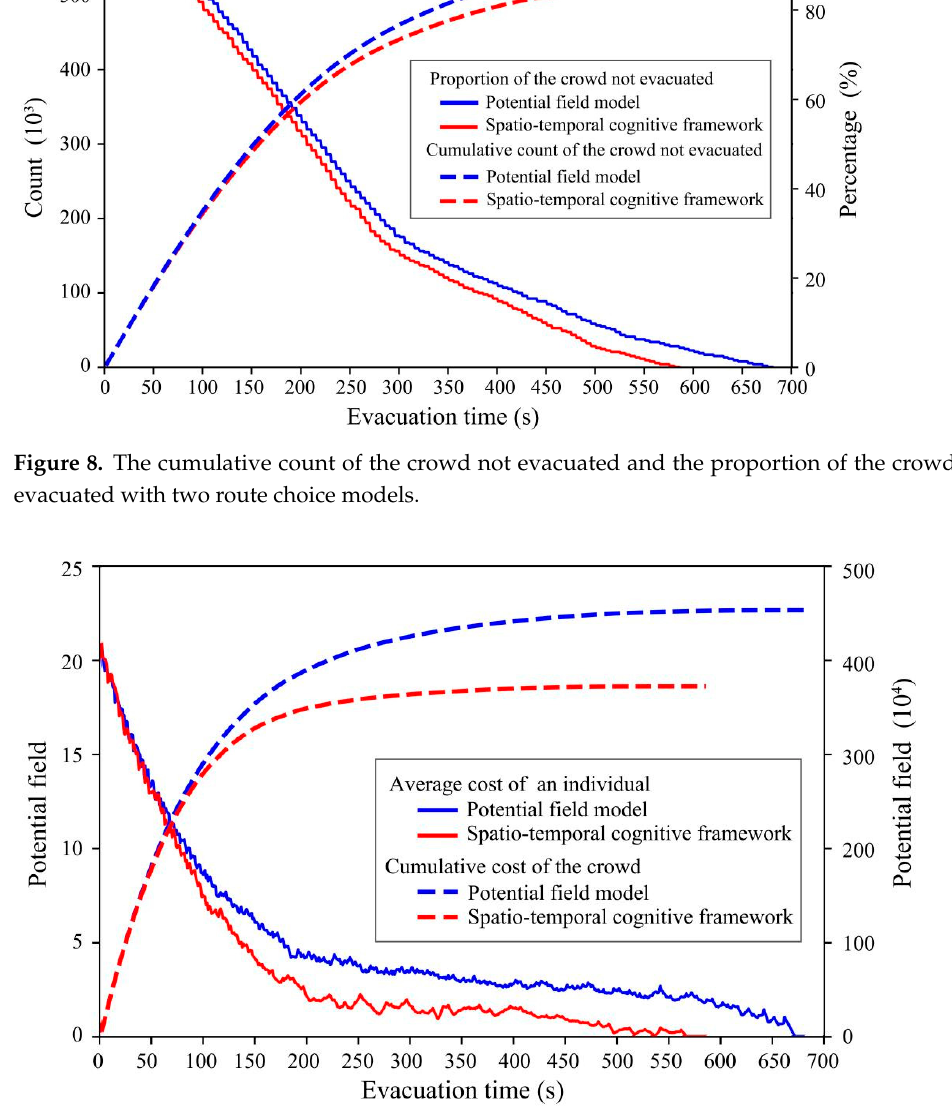
Figure 9. Individual subjectively estimated cost and cumulative cost of the crowd with two route choice models.